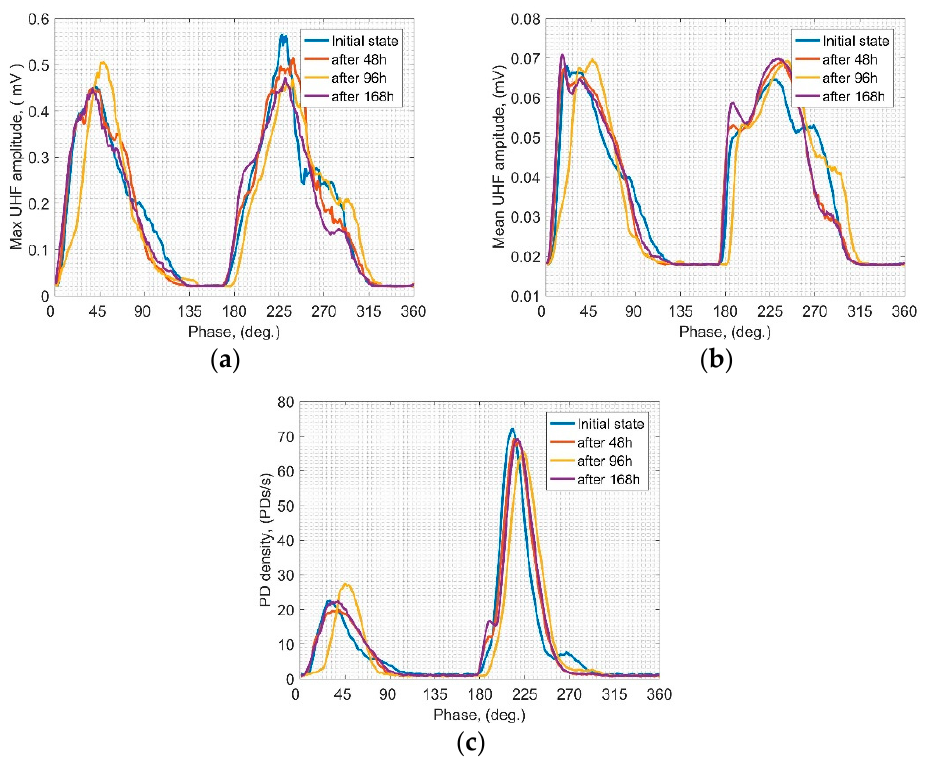
Figure 4. Means over PRPD patterns of the UHF signals emitted by SD for PTFE scenario: ( a ) max UHF amplitude; ( b ) mean UHF amplitude; ( c ) PD density.